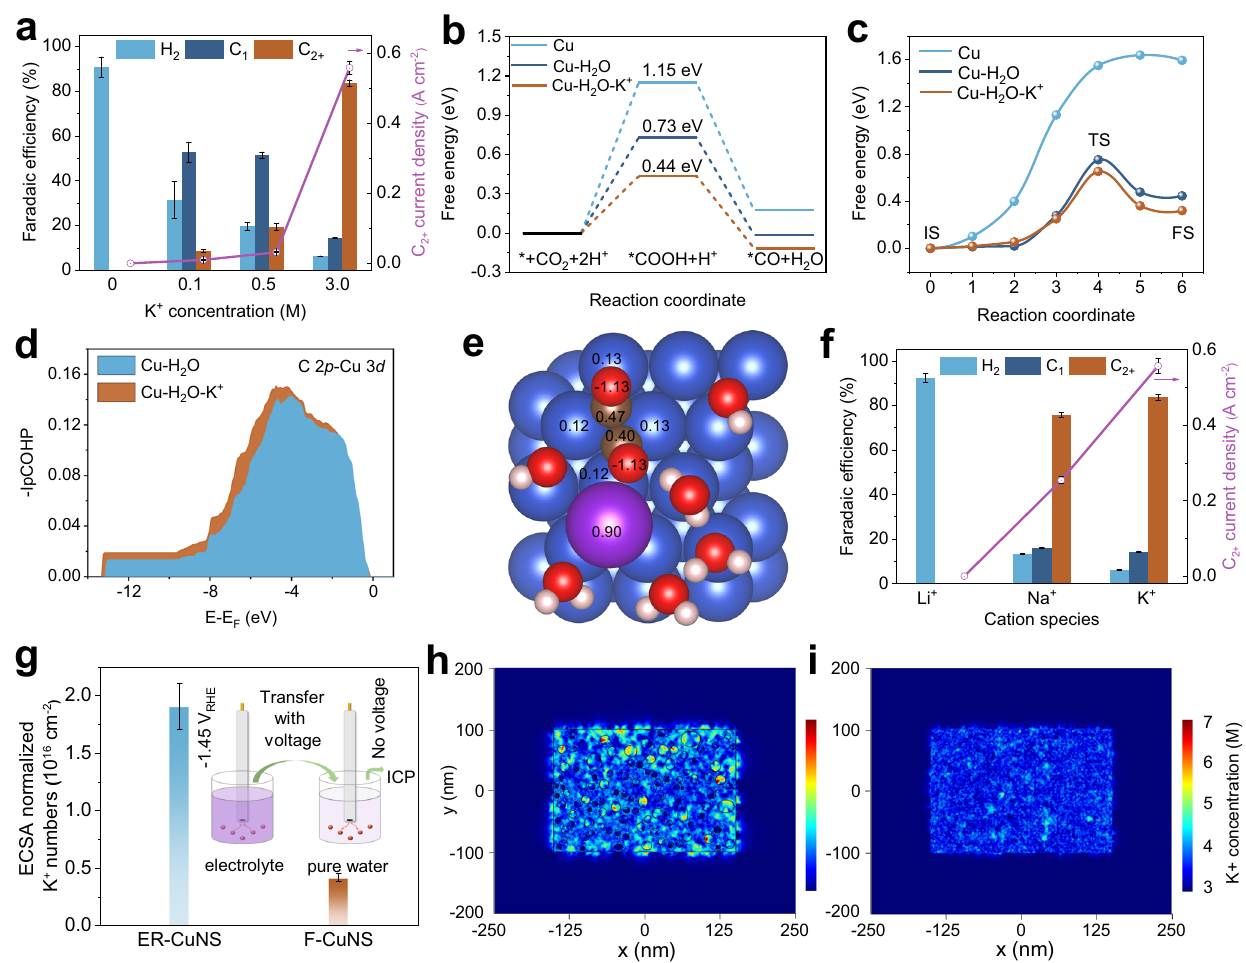
Fig. 3 | Mechanistic studies. a K + concentration-dependent FE and C 2+ current densityofER-CuNSat − 1.45V RHE . b FreeenergydiagramsofCO 2 RR-to-COpathway on Cu (111) slab (Cu), Cu (111) slab with H 2 O (Cu – H 2 O), and Cu (111) slab with H 2 O and K + species (Cu – H 2 O – K + ) on the surface. c Reaction energy barriers of *CO dimerization on different slabs. IS, initial state. TS, transition state. FS, fi nal state. d Integrated projected crystal orbital Hamilton population (-IpCOHP) curves of C 2 p -Cu3 d bondfor*OCCOintermediateadsorbedonCu – H 2 OandCu – H 2 O – K + slab. e The charge density analysis of *OCCO on Cu – H 2 O – K + slab according to the